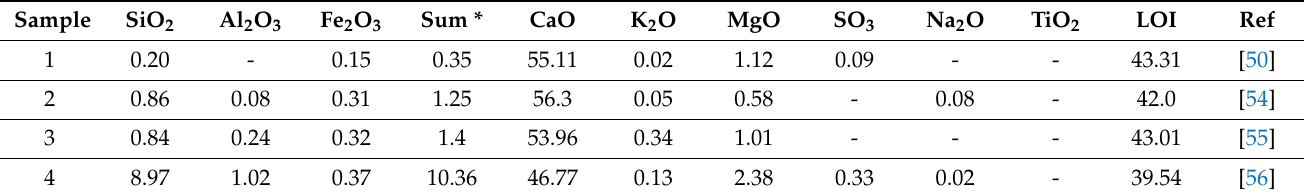
Table 1. Chemical composition of LP (Note: Sum * is the sum of pozzolanic